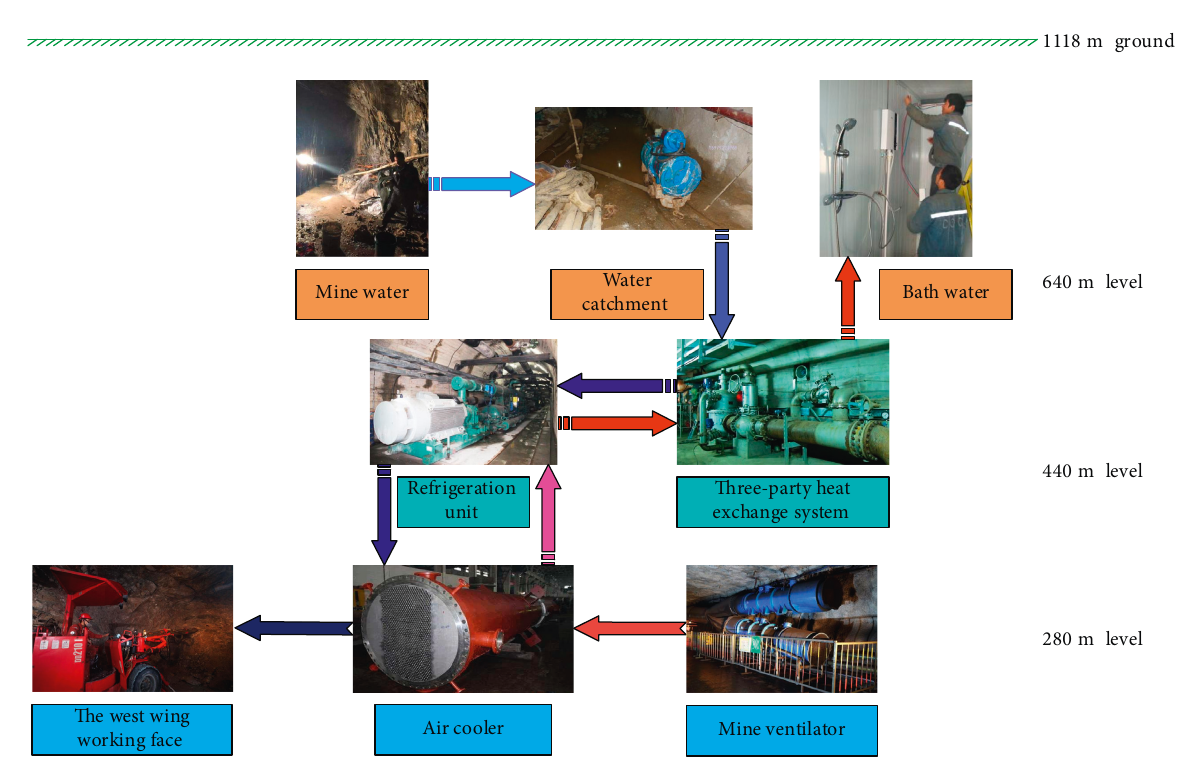
Figure 4: Design of cooling system for 1118m pit in Jinqu Gold